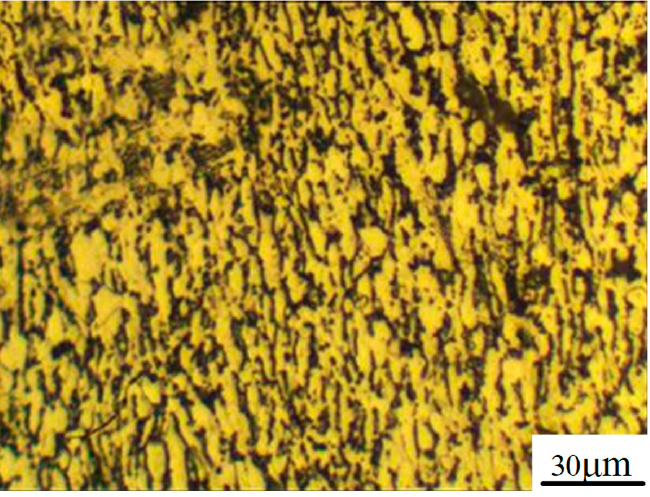
Figure 1. Metallographic structure of Ti6Al4V. Alumina polishing slurry with different grades of size was used as the polishing slurry. The samples were ultrasonically cleaned in alcohol for 10 min and dried on a clean and ventilated laboratory bench before and after